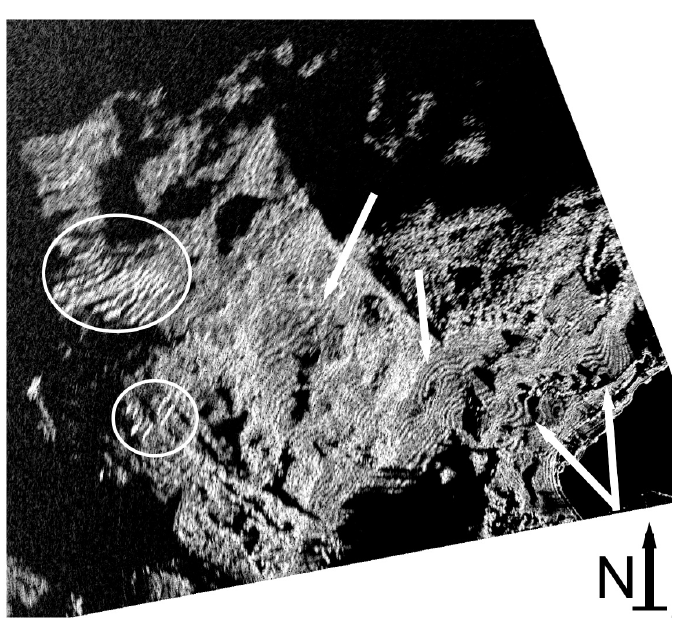
Figure 1. Backscatter intensity image showing multipath interference pattern as intensity undulations following the topography. Data was acquired in the Davos test site (Section 1.2.1) in VV polarisation on 1 October 2016. We performed temporal multilooking over 10 consecutive images acquired within 30 min to reduce speckle. Arrows point to the most prominent multipath interference features. Note that the bright features circled in white are avalanche protection structures that have a similar looking